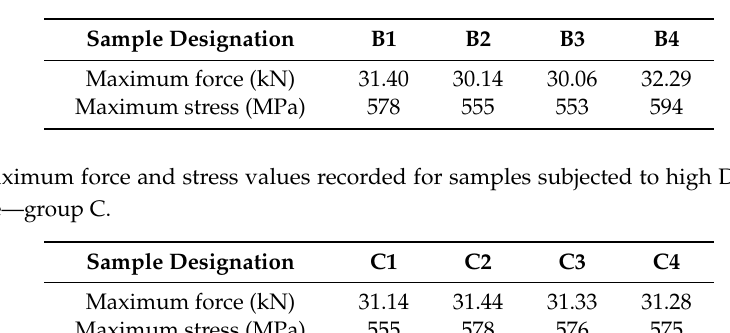
Table 2. Maximum force and stress values recorded for samples subjected to temperature—group B.